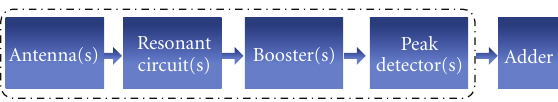
Figure 4: System diagram of RF